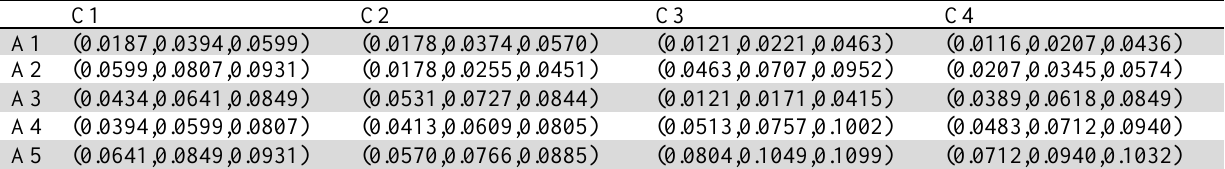
Weighted normalized fuzzy decision matrix for